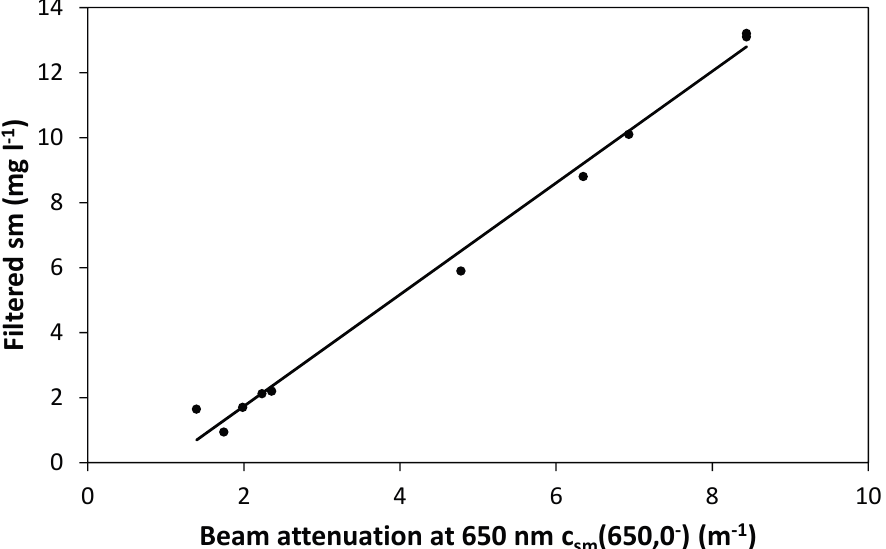
Figure 2. Scatter plot between beam attenuation at 650 nm at sub-surface and gravimetrically measured sm. Best linear fit: sm(0 − ) = 1.717c units of mg · L − 1 and m − 1 , respectively. Coefficient of determination: R 2 =